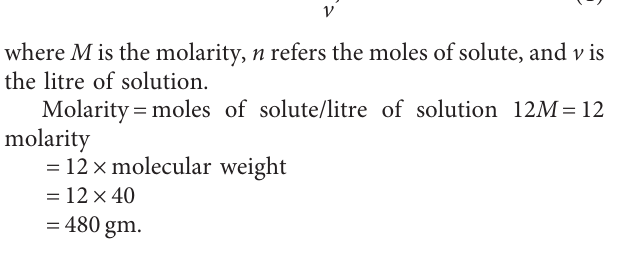
Table 4: Mix proportions for GPC.